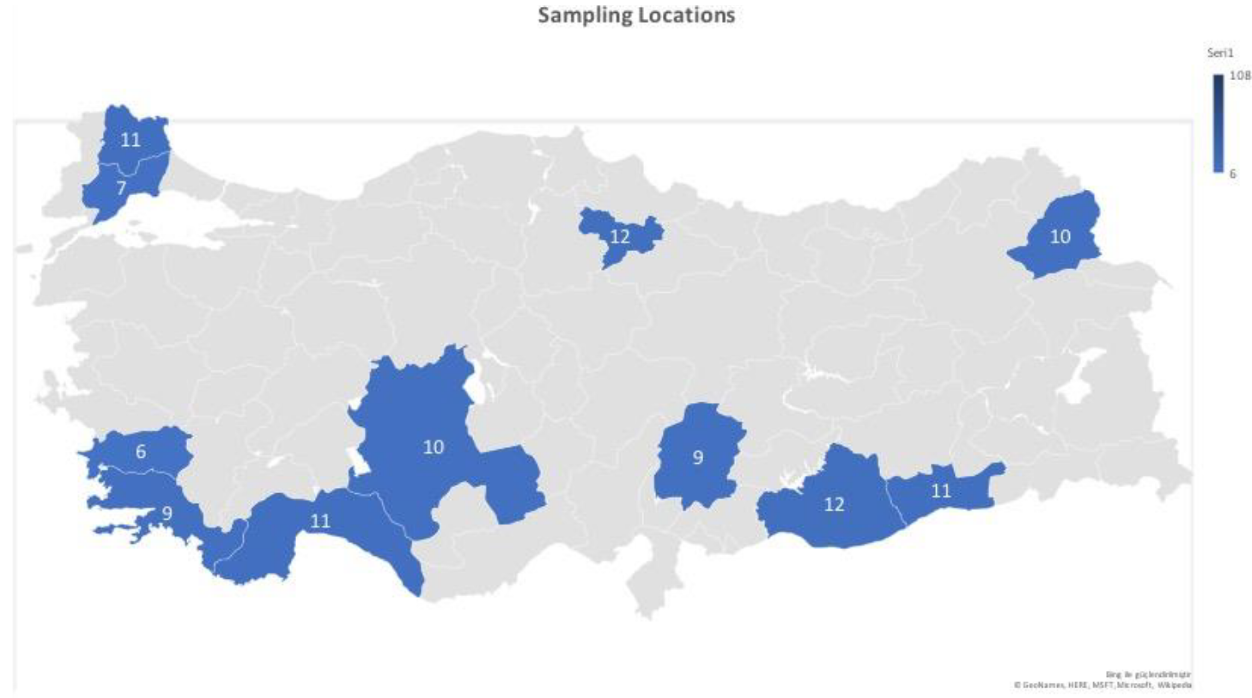
Figure 2. The sampling locations and the sample sizes of donkeys used in this study. ©GeoNames, Microsoft, Navteq, Wikipedia (the Turkey map is created with Microsoft Excel enhanced via